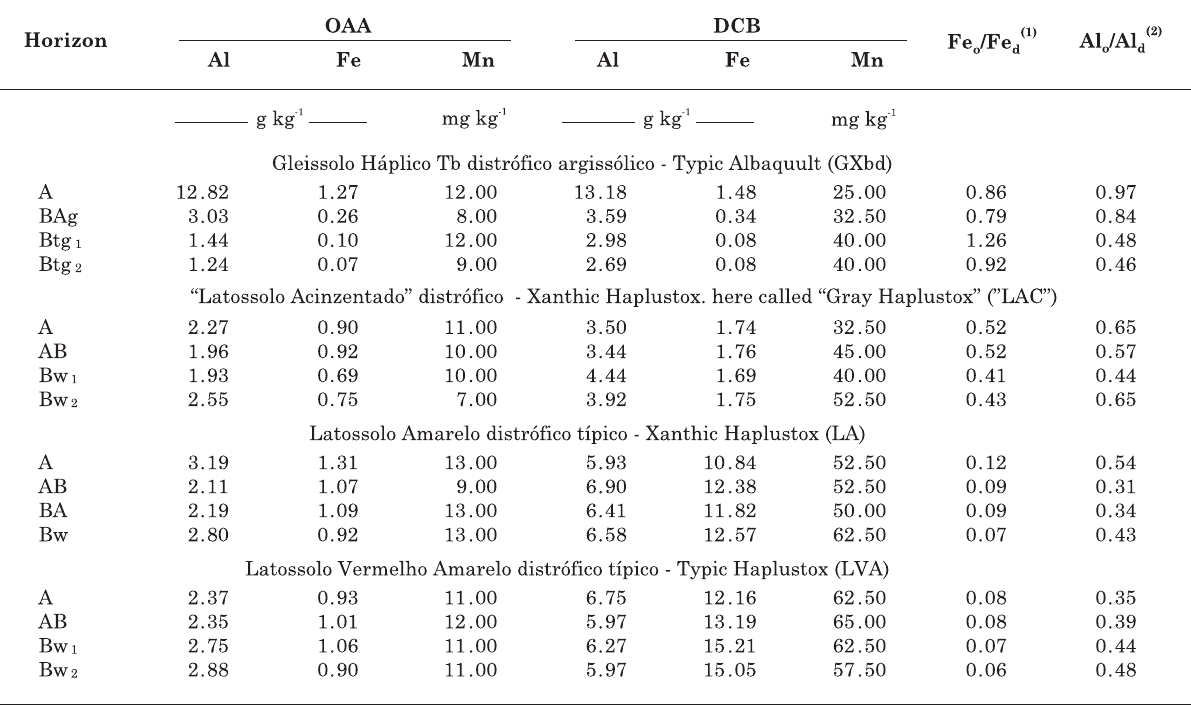
Table 5. Iron, Al and Mn content originating from OAA and DCB extracts, and their relations with soils in the toposequence on the slope of the Lagoa do Leandro